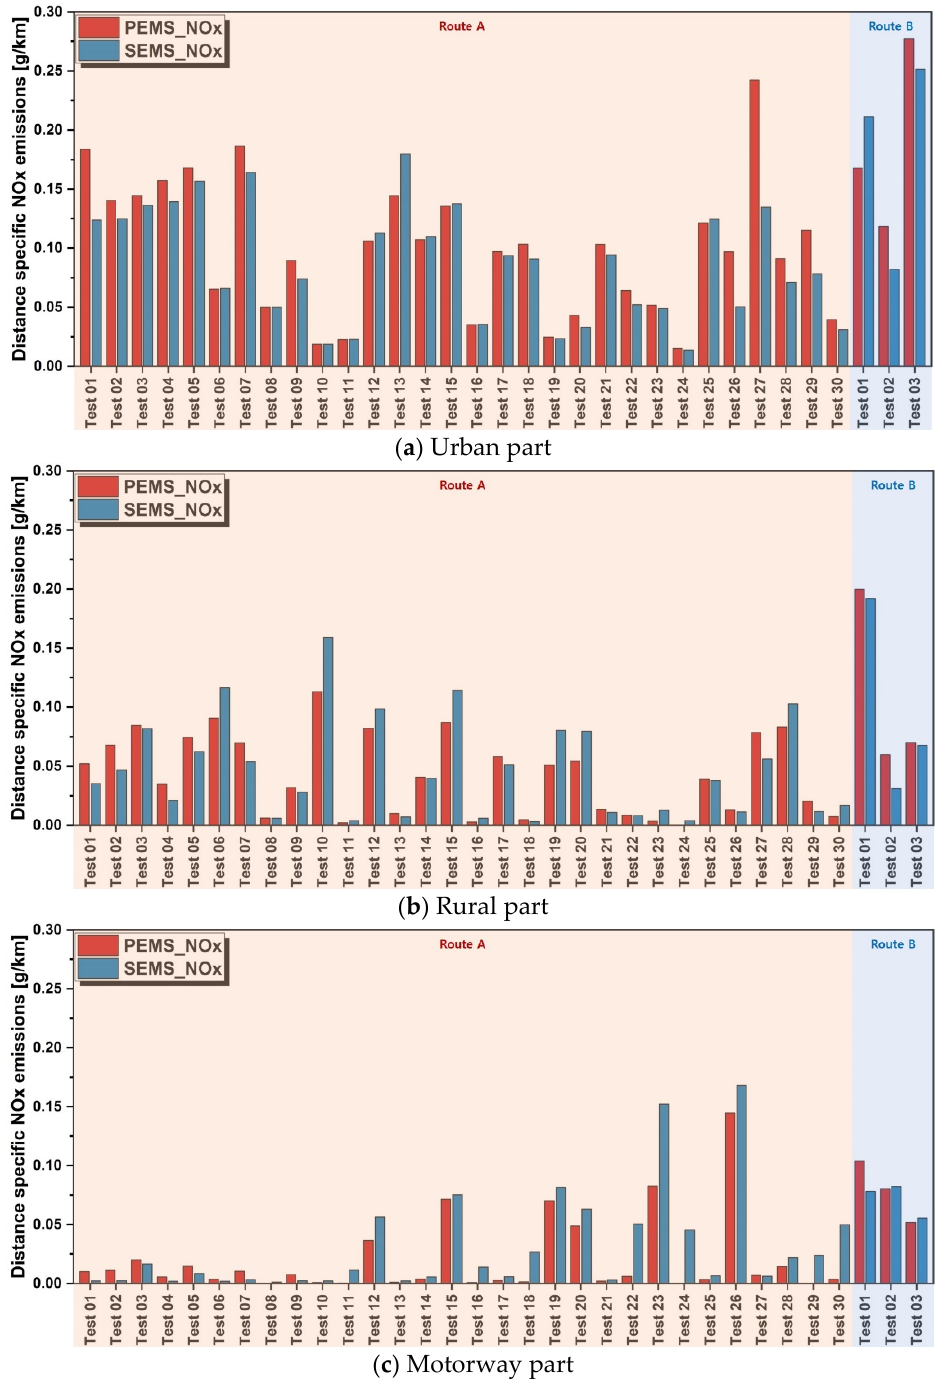
Figure 17. NOx emissions measured by the PEMS and SEMS equipment under RDE tests in Routes A and B. A and